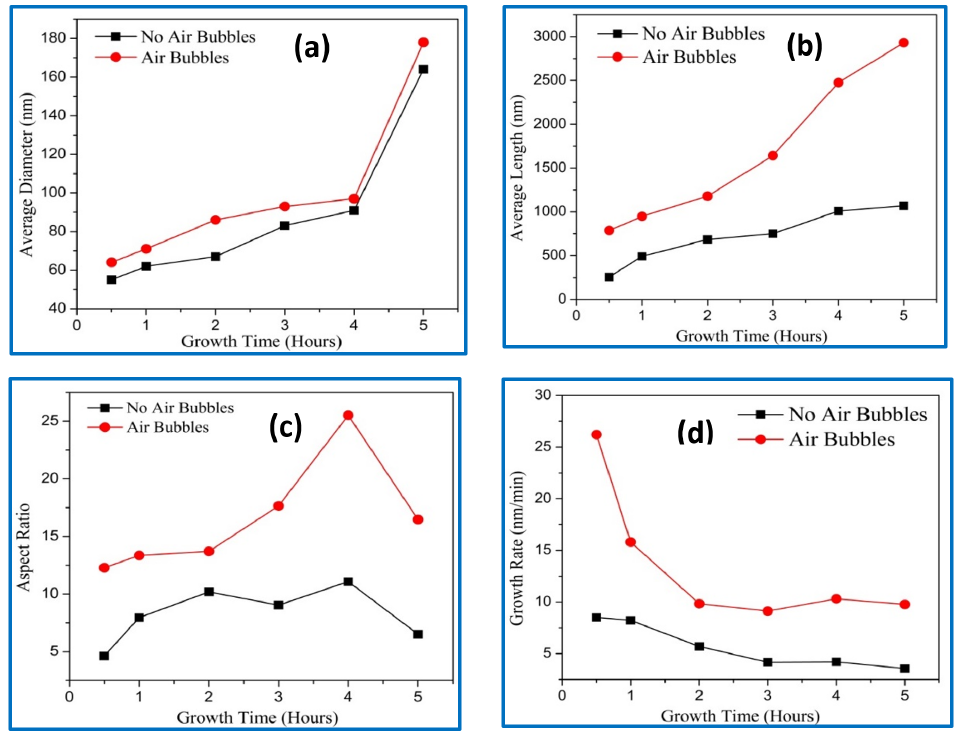
Figure 5. Effect of different growth times on the ZnO NRs grown using conventional and modified chemical bath deposition (CBD) methods: ( a ) average diameter, ( b ) average length, ( c ) aspect ratio, and ( d ) growth rate.